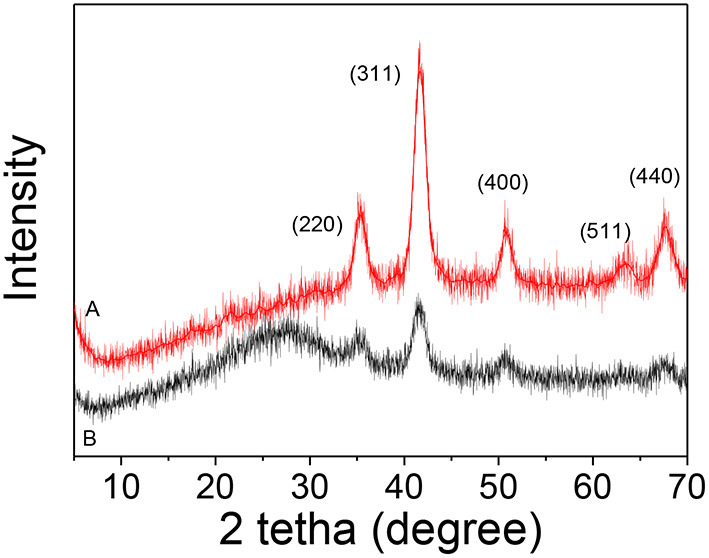
XRD patterns: (A) Fe3O4 and (B) Fe3O4@SiO2.